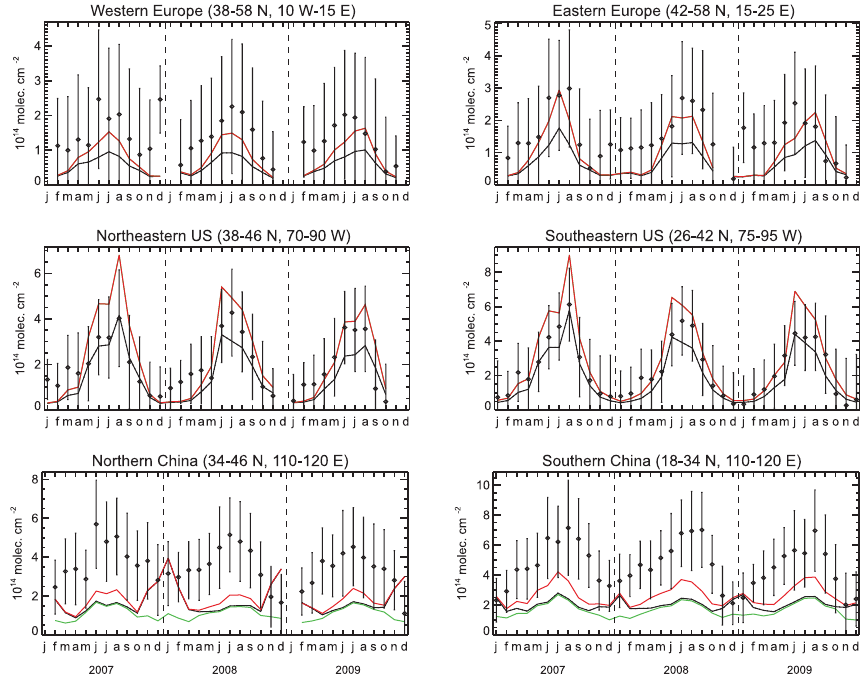
Fig. 13. Modelled and observed glyoxal column time series for selected tropical regions. The lines represent the standard simulation (in black) and the simulations with halved (S3 – in green) or doubled (S4 – in red) biomass burning emissions of glyoxal and its precursors.